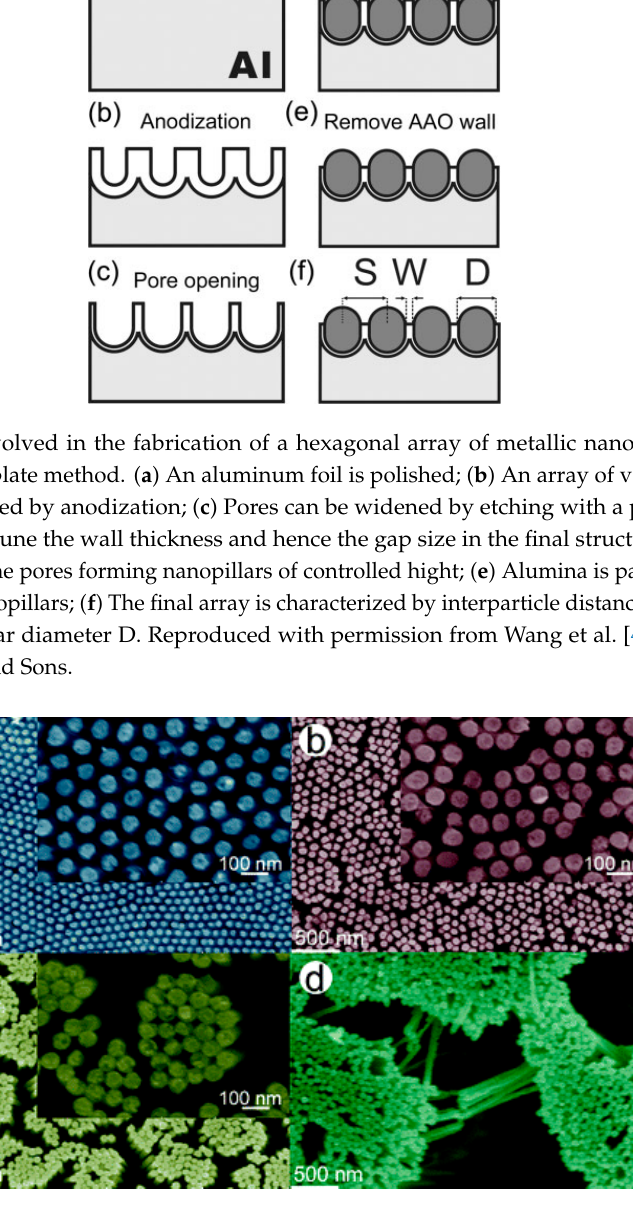
Figure 31. SEM images of the sample after (partial) dissolution of the alumina template with NaOH at different etching times: 0 s ( a ), 210 s ( b ), 270 s ( c ), and 450 s ( d ). The controlled etching of the template makes the nanopillars collapse on each other, generating tip–tip hot spots. Reproduced with permission from Lee et al. [350]. Copyright (2006), the American Chemical Society.